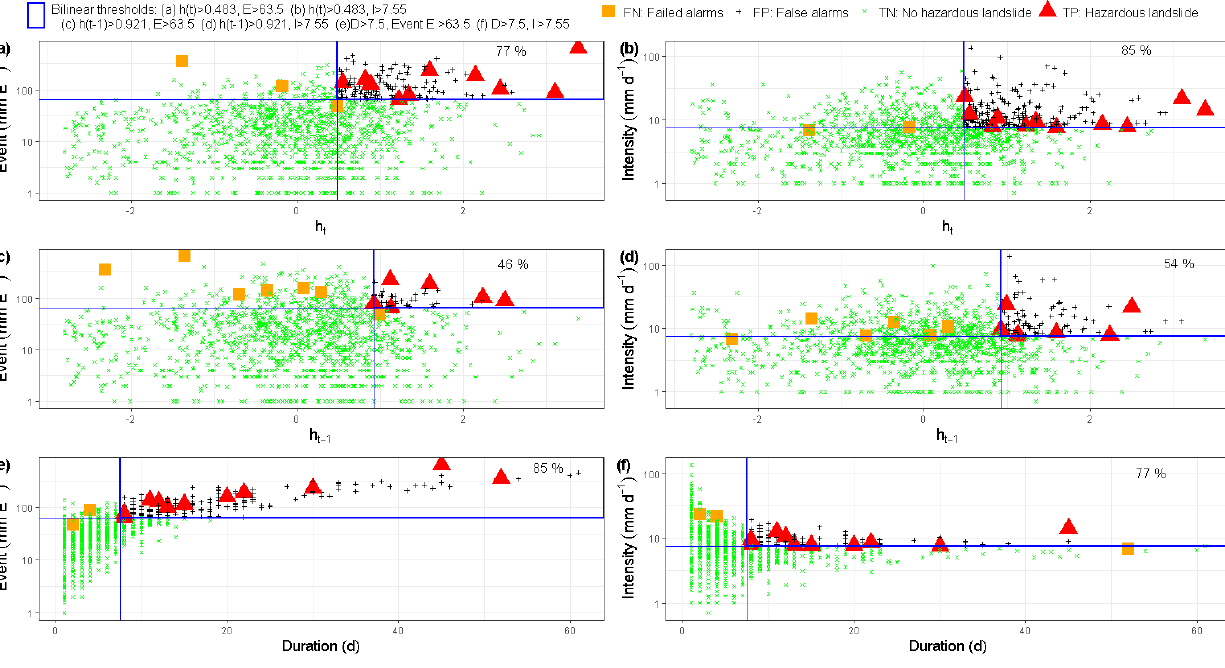
https://doi.org/10.5194/nhess-22-1723-2022 Nat. Hazards Earth Syst. Sci., 22, 1723–1742,